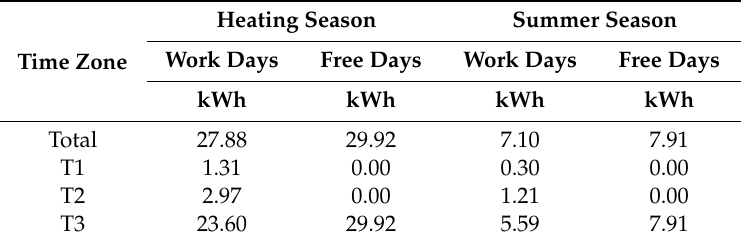
Table 2. Average daily imported energy in the summer and heating seasons for work days and free days.